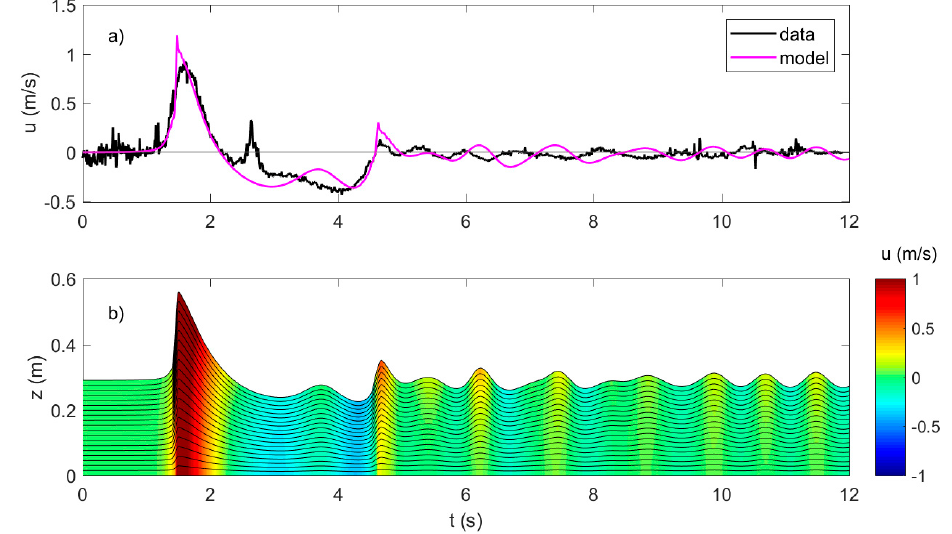
Figure 6. Water surface elevation time series for the high landside mobility case from experimental observations and numerical simulation. Time t = 0 s is referenced to the slide impact time. Wave probe sites shown in Figure 1 are: ( a ) P1; ( b ) P2; ( c ) P3; ( d ) P4; ( e ) P5; and ( f ) P6.